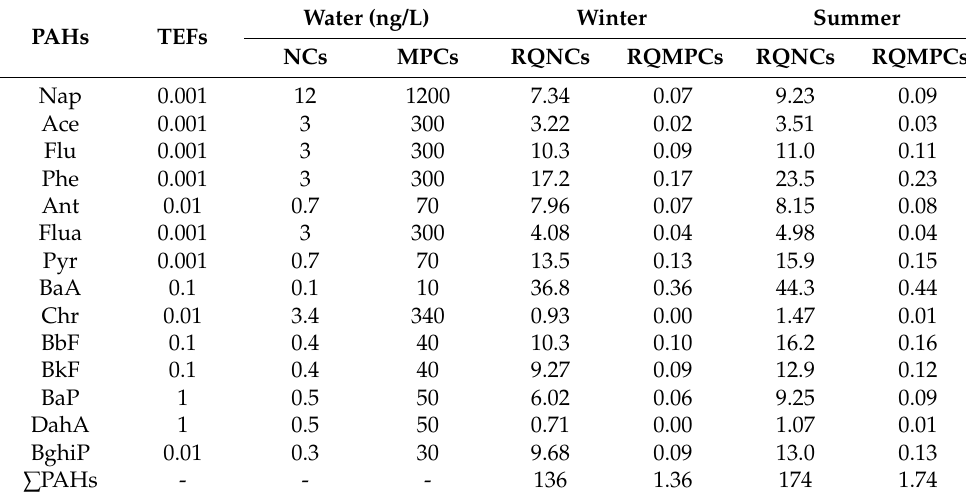
Table 2. Mean values of RQ (NCs) and RQ (MPCs) of PAHs in the surface river water of the Songhua